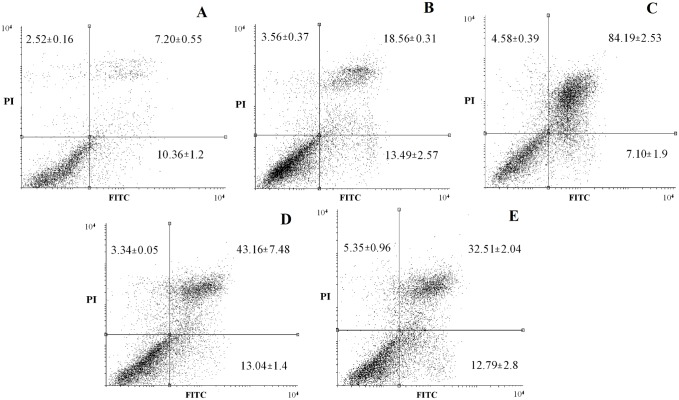
Annexin V-FITC and propidium iodide staining of HepG2 treated with 1,3,4-thiadiazolium derivatives (the experimental conditions are described in the Materials and Methods section 2.5.3).The cells were seeded with or without 1,3,4-thiadiazolium derivatives at 25 μM for 18–24 h. Then, the cells were collected with trypsin and 10.000 events were analyzed by flow cytometry by FL2 and FL1 filters. (A) control, (B) MI-D, (C) MI-J, (D) MI-4F and (E) MI-2,4diF. The figures show representative dot-plot with the different cell populations: left-bottom = labeled cells; left-top = PI labeled; right-top = doubly labeled; right-bottom = annexin V labeled. The results were expressed as mean ± SD of three independents experiments.